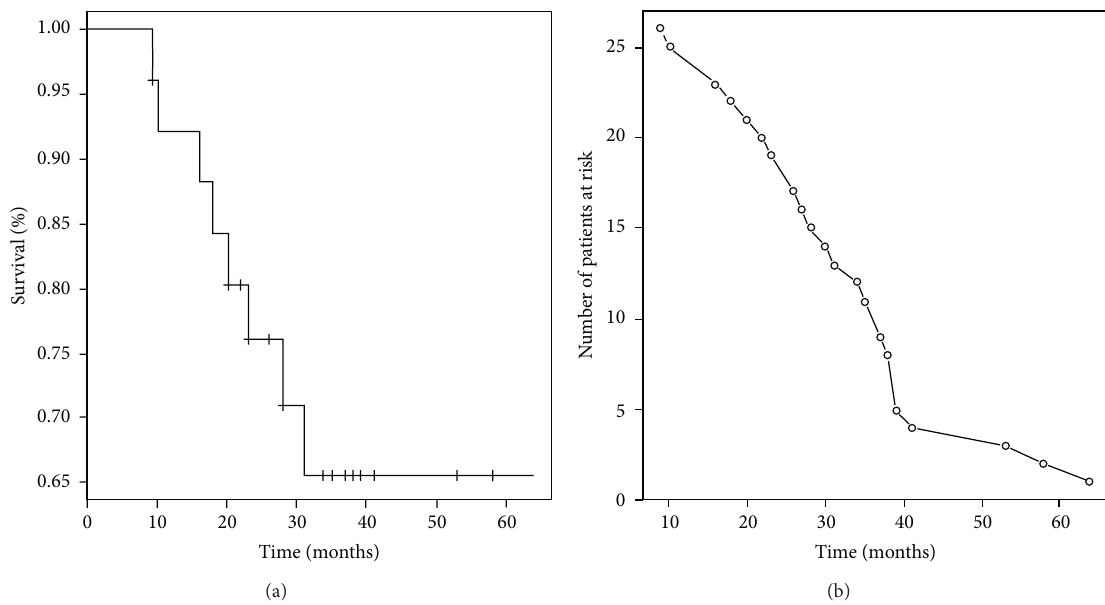
Figure 1: The cumulative Kaplan-Meier survival plot. (a) Survival of 25 IPF patients followed till death (uncensored: 𝑛 = 8 ) or reporting of the study (censored: 𝑛 = 17 ), combined by a plot (b) where the number of patients at risk is shown.